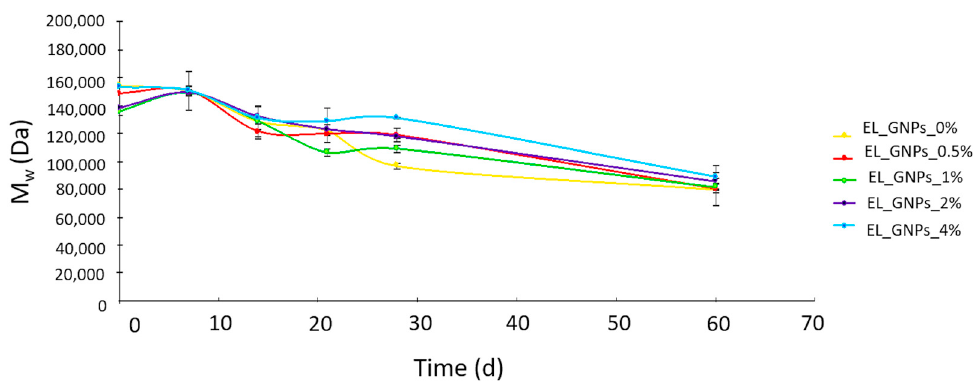
Figure 6. Changes of molecular weight (M w , Da) of neat EL_GNP_0% and EL_ GNPs composite matrices incubated with DMEM (10% FBS, 1% antibiotics) at 7, 14, 21, 28 and 60d.